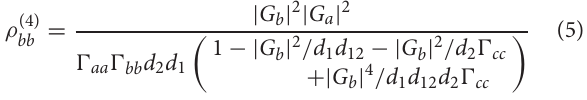
Figure 4F shows theoretical predications of